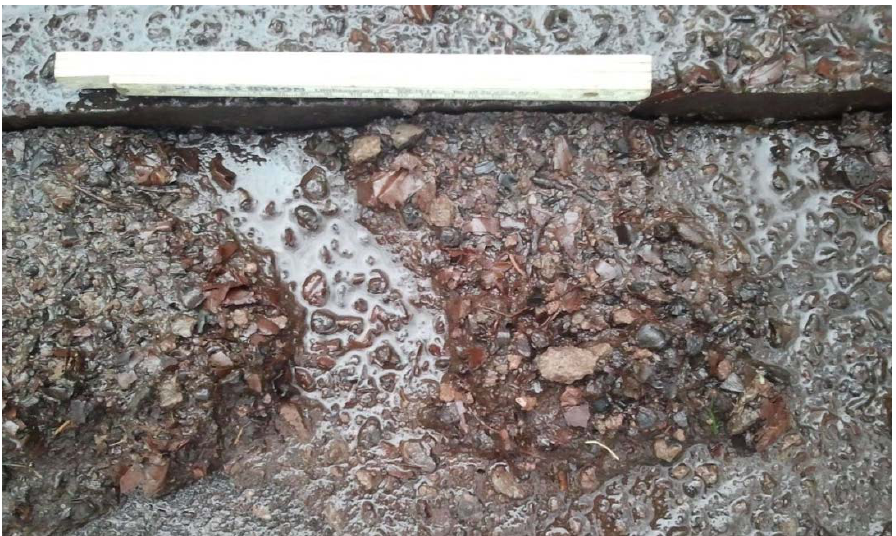
Figure 9. Residual accumulation of coarse material after 90 min of artificial rainfall, rule (0.23 m) for scale.